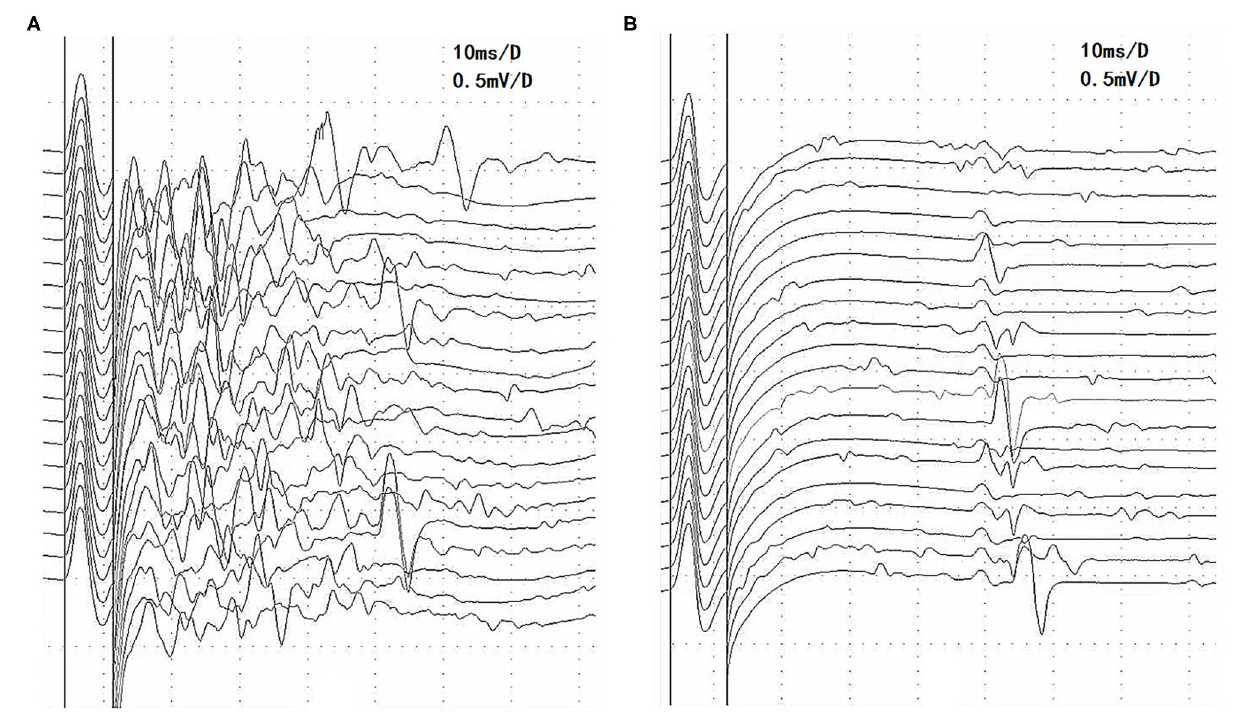
afterdischarges on RNS differed between MuSK-MG and AchR- MG in this study, indicating that the pathological mechanisms underlying the afterdischarges may be